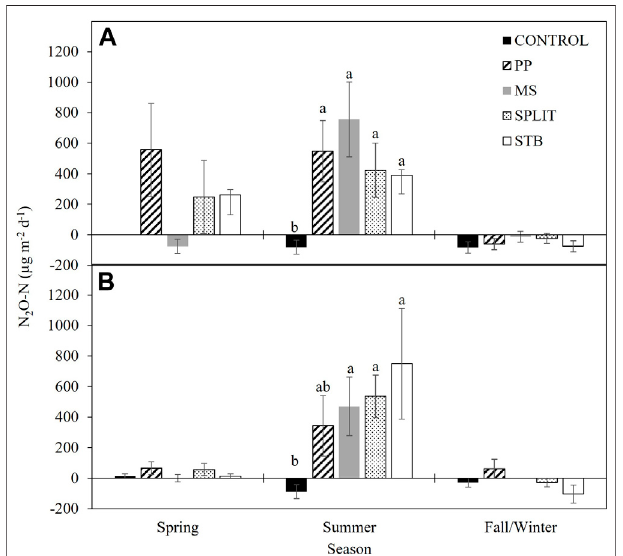
FIGURE 4 | Nitrous oxide emissions in (A) 2016 and (B) 2017 averaged by season. PP, pre-plant nitrogen (N) fertilizer application; MS, mid-season N fertilizer application (applied at pinhead square); SPLIT, 40% PP 60% MS N fertilizerapplication; STB,100%PPapplicationwithNstabilizerproduct. Spring, April — May; Summer, June — September; Fall/Winter, October — March. Seasonal treatment means with the same letter are not different at α (cid:1) 0.1. Error bars are standard error. FIGURE 5 | Average cumulative N 2 O-N emissions from cover crop